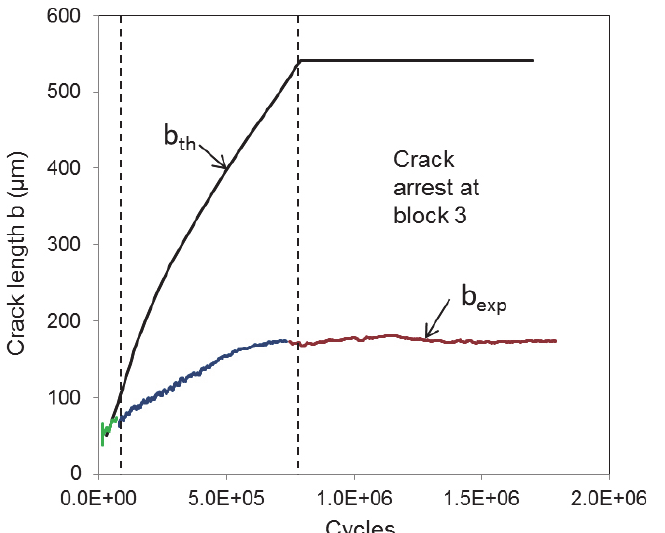
Figure 11: Comparison of theoretical crack propagation rate calculated with the predictive method and experimental crack propagation rate. Loading: R=4.6mm, P, Block 1 : σ F,moy / σ y,flat =0.78, R σ =0.85, Q*/P=0.3, N=70000; block 2 : σ F,moy / σ y,flat =0.78, R σ =1, Q*/P=0.3, N=670000; block 3 : σ F,moy / σ y,flat =0.78, R σ =0.85, Q*/P=0.15,